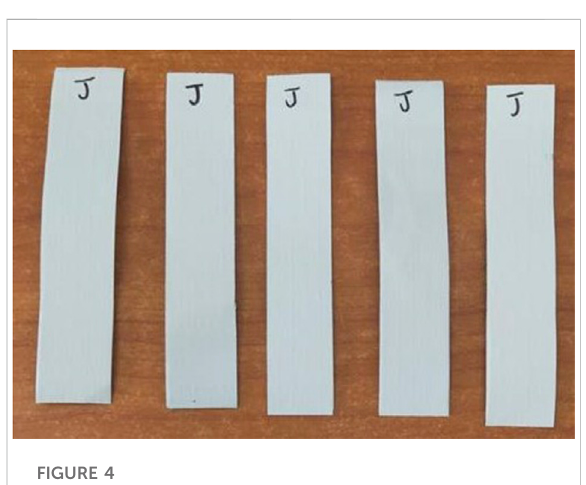
FIGURE 4 Tensile specimen and its schematic